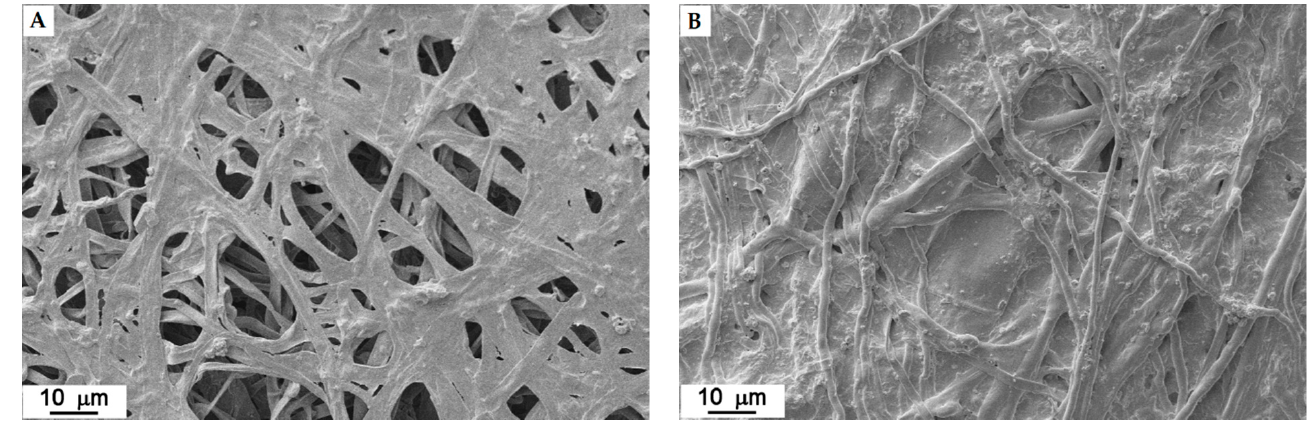
15 of 22 Figure 9. Different kinds of mycelia in strains: ( A ) Coriolopsis trogii (5), ( B ) Irpex lacteus (14), ( C ) Daedaleopsis confragosa (6),